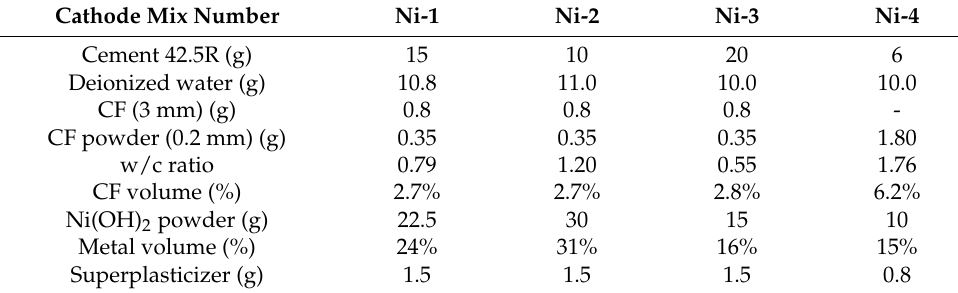
Table 6. Mix proportions of the “powder-mixing” cathodes.